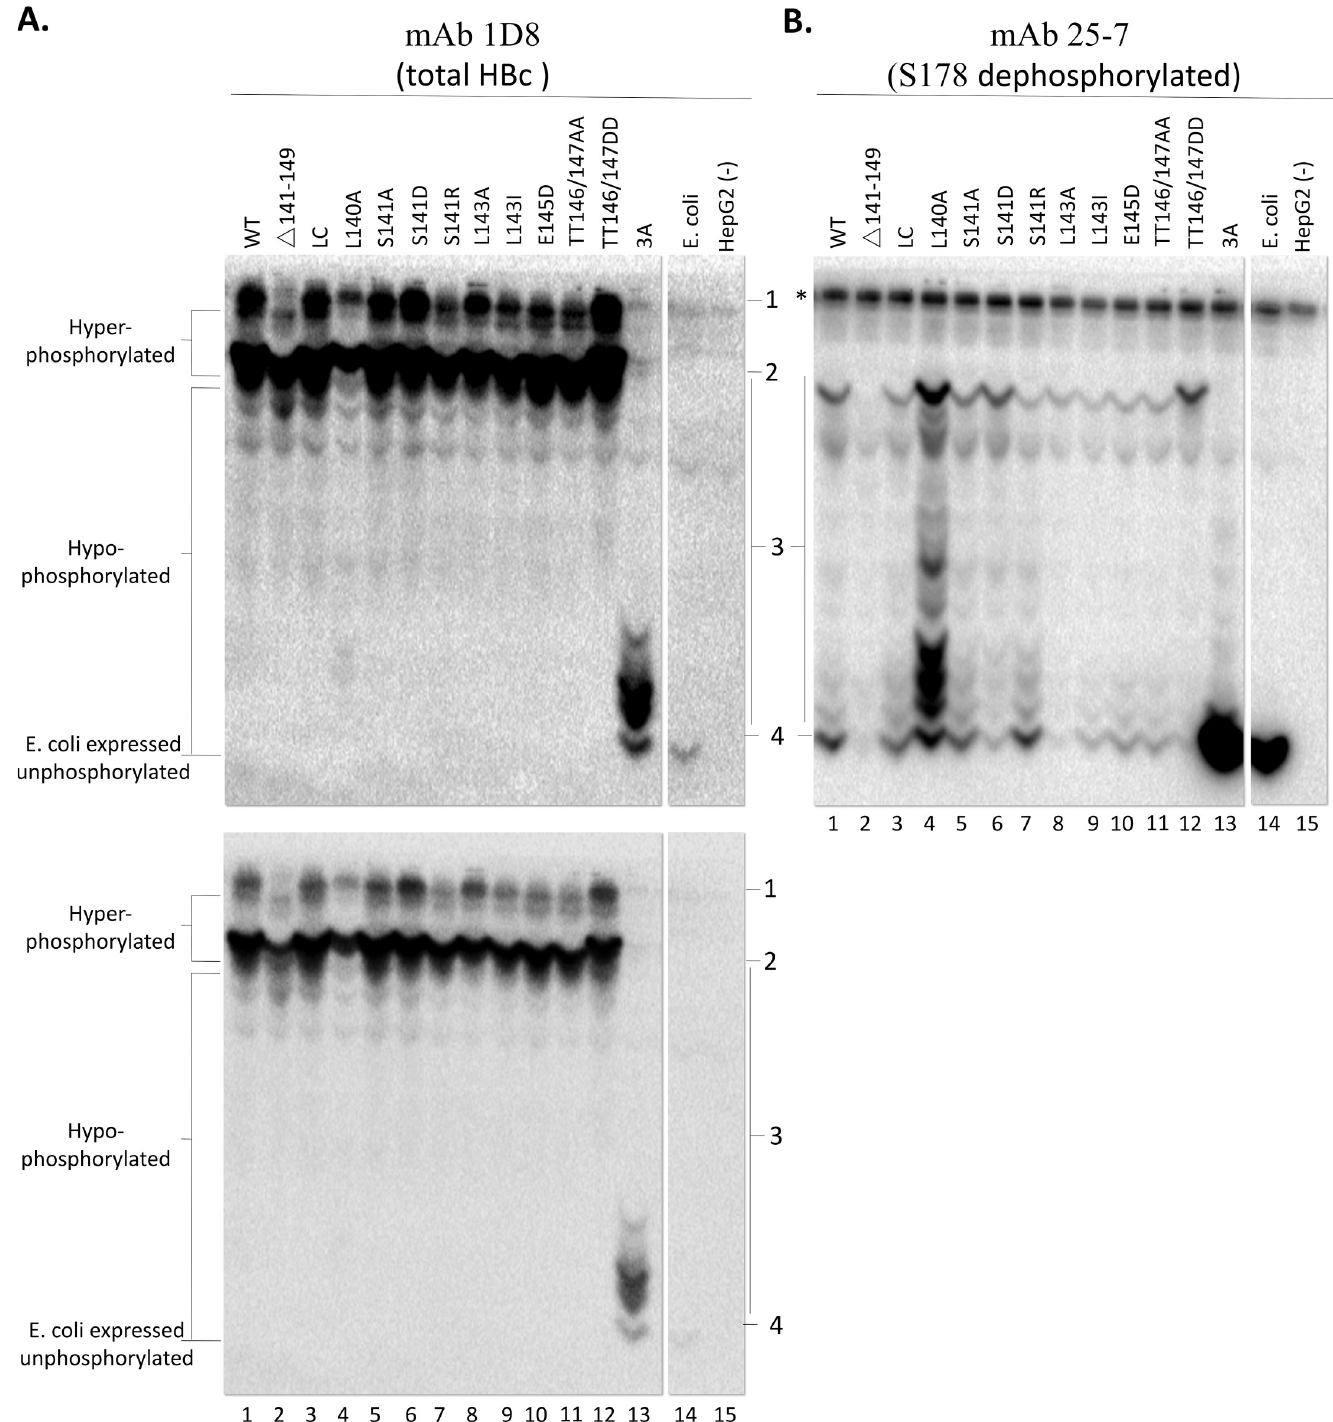
Fig 3. Phos-Tag SDS-PAGE and immunoblot analysis of HBc linker mutants. HepG2 cells were transfected with HBc mutants expression constructs and harvested seven days post-transfection. Cytoplasmic lysates of the transfected cells were resolved by Phos-tag SDS-PAGE and detected by western blot analysis, using the HBc NTD mAb 1D8 for total HBc ( A ) or 25–7 for dephosphorylated S178 ( B ). 1 & 2, hyperphosphorylated HBc species; 3, hypophosphorylated HBc species; 4, non- phosphorylation HBc, � , non-specific signal. The top and bottom panels in A are long and short exposure of the same membrane.